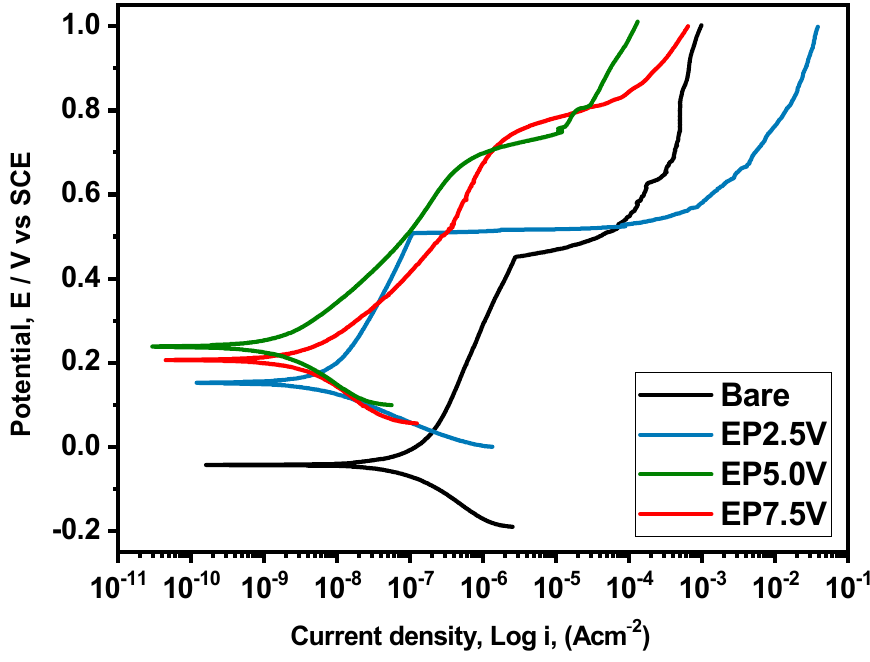
Figure 4. PDP curves of untreated and treated 316L SS specimens.